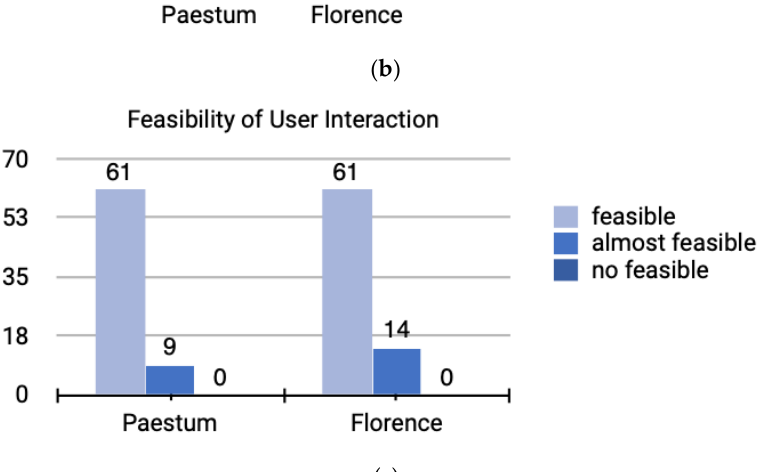
Figure 17. Preferences out of 70 + 75 responses to the question “ What did you feel immersed in exploration ?”. Figure 18 shows the percentage of a closed question about users’ preferences after their VR experience. Users were given five possible answers, with multiple-choice option. What was mostly liked by users were in line with other collected data: -